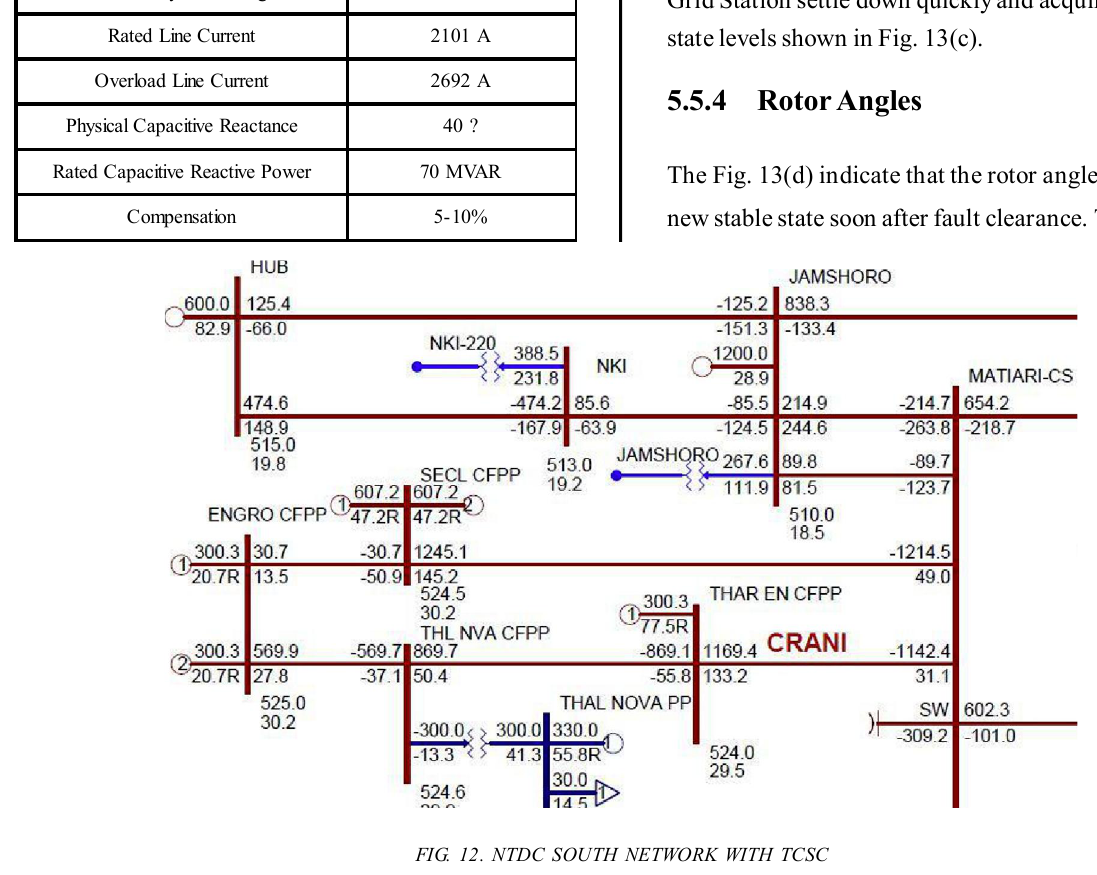
FIG. 12. NTDC SOUTH NETWORK WITH